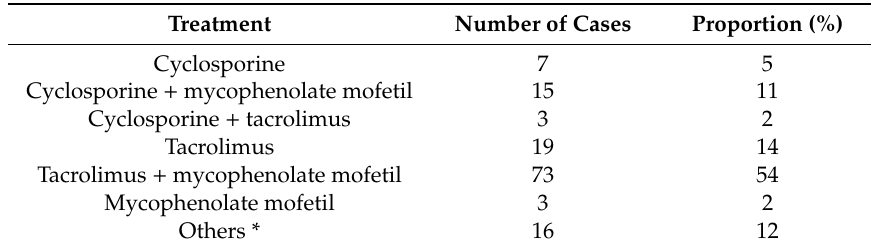
Immunosuppressive treatments in solid organ transplanted patients with notified cryptosporidiosis.